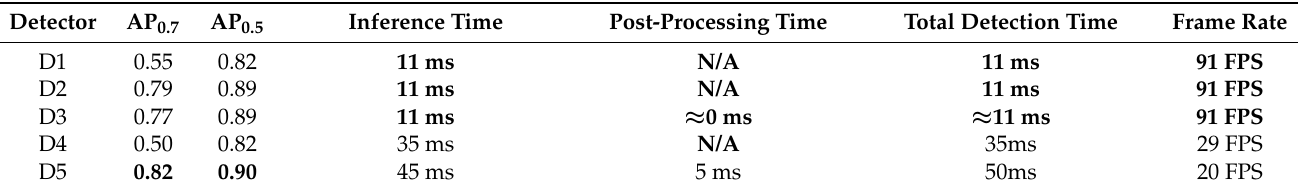
Table 2. Average Precisions, inference, post-processing times and Frame Rate. The GPU used for measuring inference times is an Nvidia Quadro RTX 3000 Mobile. Post-processing times are computed with a chosen confidence score threshold of 0.5 as explained in Section 4.2. Bold numbers indicate best results in each